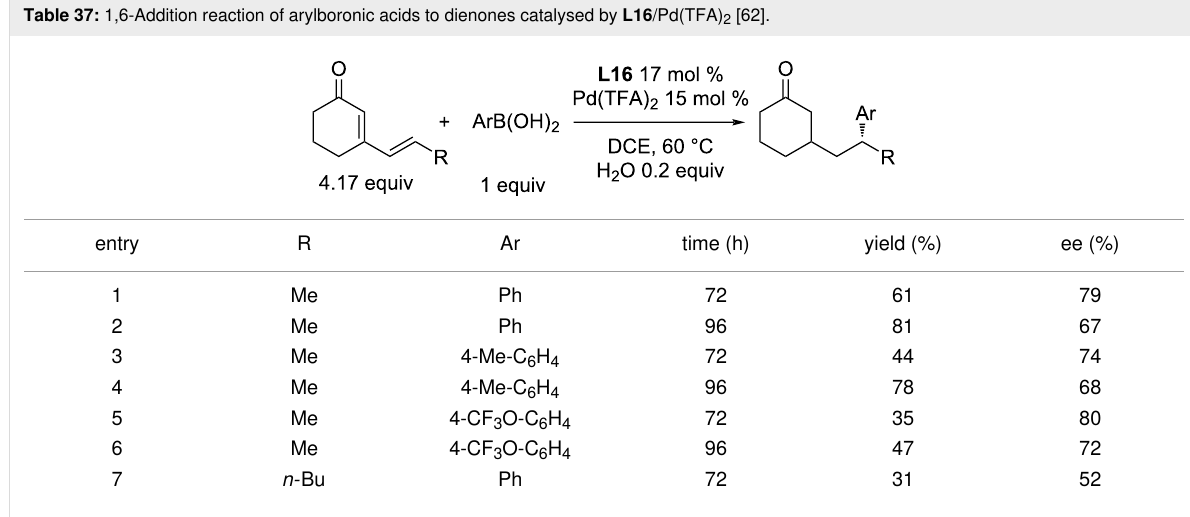
Table 37: 1,6-Addition reaction of arylboronic acids to dienones catalysed by L16 /Pd(TFA) 2